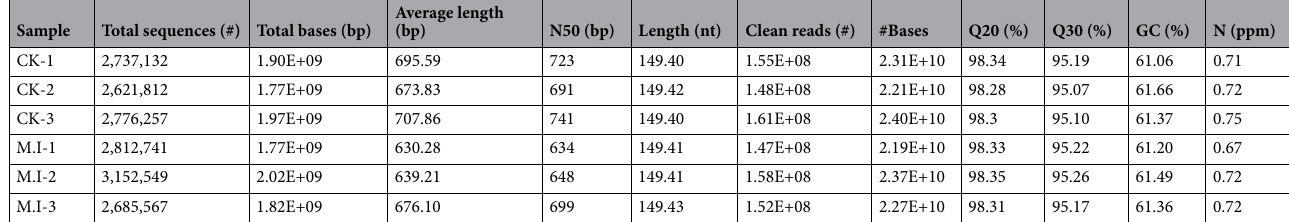
Table 2. Sequencing data of macrogenes of the pristine forest forests and M. micrantha -invaded forest.